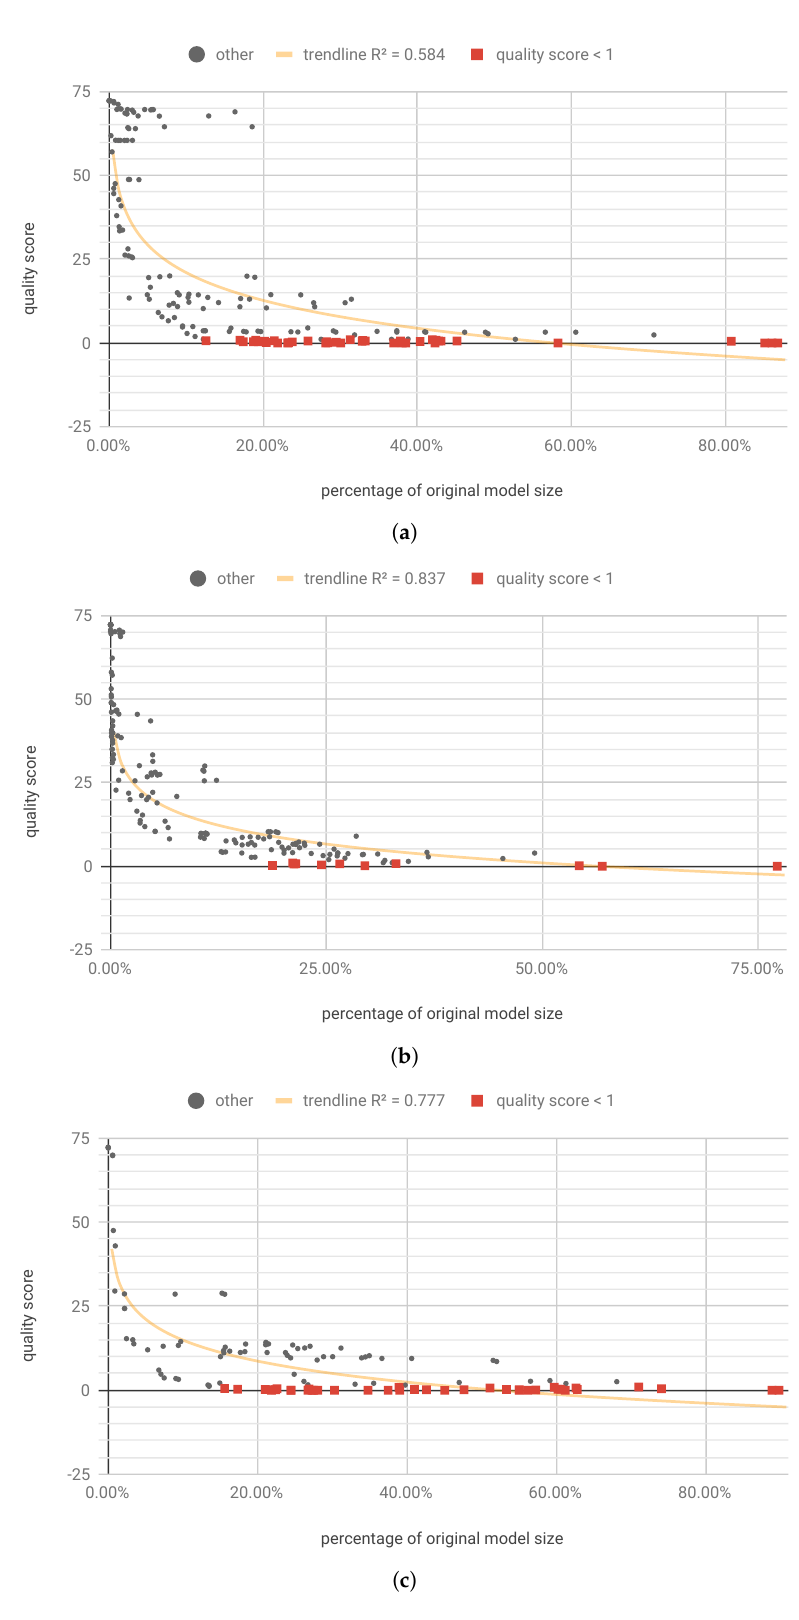
Figure 11. [PM2.5] Unique first Pareto front results. ( a ) Flow A: per-model pruning and quantization. trendline ( x ) = − 6.6 − 12ln x ; ( b ) flow B: individualized pruning and quantization. trendline ( x ) = − 4.65 − 8.13ln x ; ( c ) flow C-A: pruning and quantization with single retraining epoch. trendline ( x ) = − 5.87 − 9.04ln x